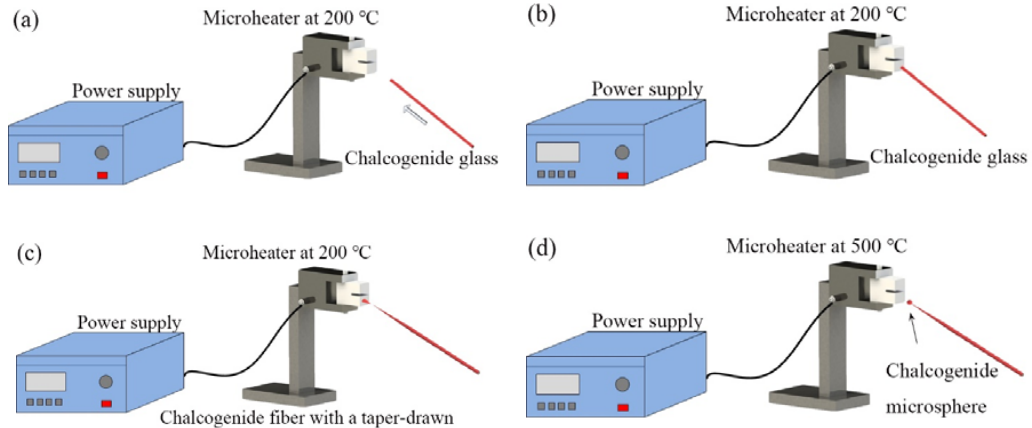
Figure 5. Experimental step for fabricating a chalcogenide microsphere. ( a ) Chalcogenide glass is moved to a microheater at 200 °C; ( b ) the chalcogenide glass is attached on the surface of microheater; ( c ) the chalcogenide glass is drawn to a half tapered fiber; ( d ) a chalcogenide microsphere is formed.